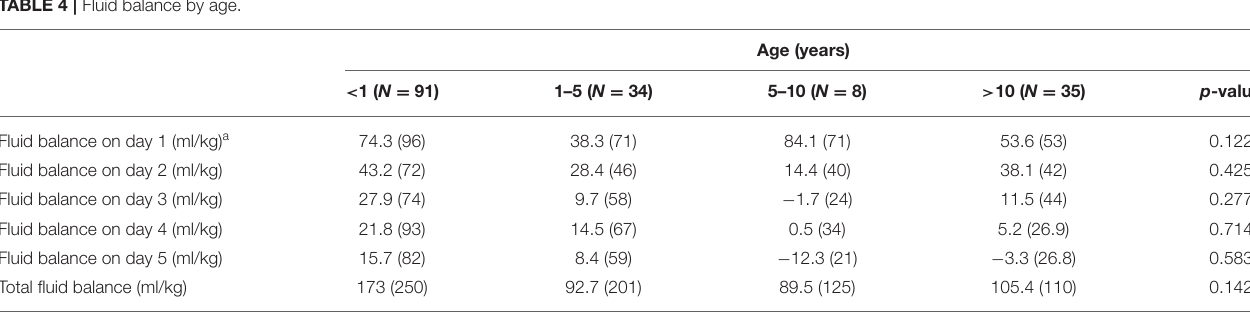
TABLE 4 | Fluid balance by